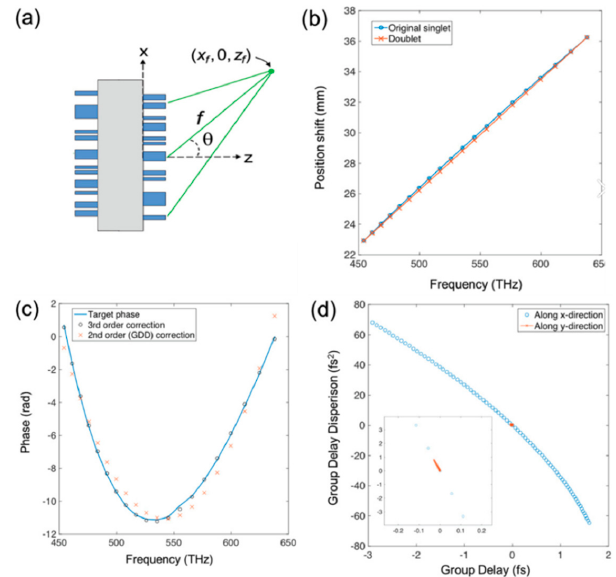
Figure 17. Compact aberration-corrected spectrometer characterizations. ( a ) Schematic of a doublet, comprising of a metasurface corrector and the original aberration-corrected off-axis metalens. The corrector serves to impart group delay (GD) and group delay dispersions (GDDs) such that the focal spot positions of the metalens are linear in frequency. ( b ) Plots of the focal spot positions of the singlet metalens ( blue ) and the doublet ( orange ) as a function of frequency. ( c ) Plot of the required phase as a function of frequency for an element at the edge of the metasurface corrector ( blue line ), and the results of second- and third-order polynomial fits ( orange crosses and black circles , respectively). ( d ) GD and GDD values required for elements across the middle of the metasurface corrector, along x and y directions ( blue circles and orange crosses ). Inset: magnified view of the dispersion required for elements along y , which is minimal, due to the choice of the orthogonal camera plane. (Reproduced from [107] with